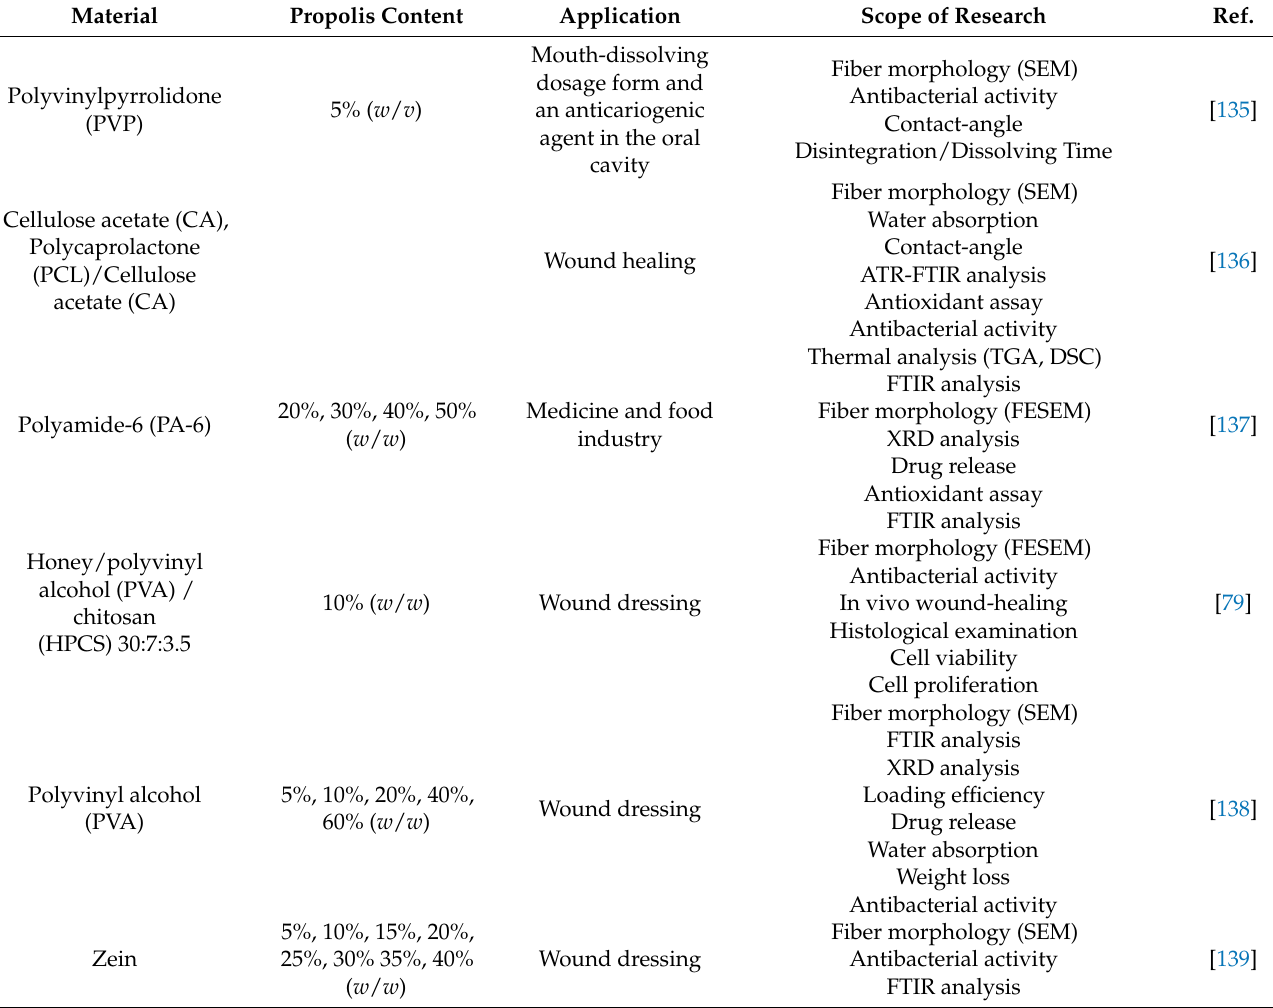
Table 2. Research on electrospun nonwovens containing propolis taking into account their potential applications and the scope of research. Material Application Scope of Research